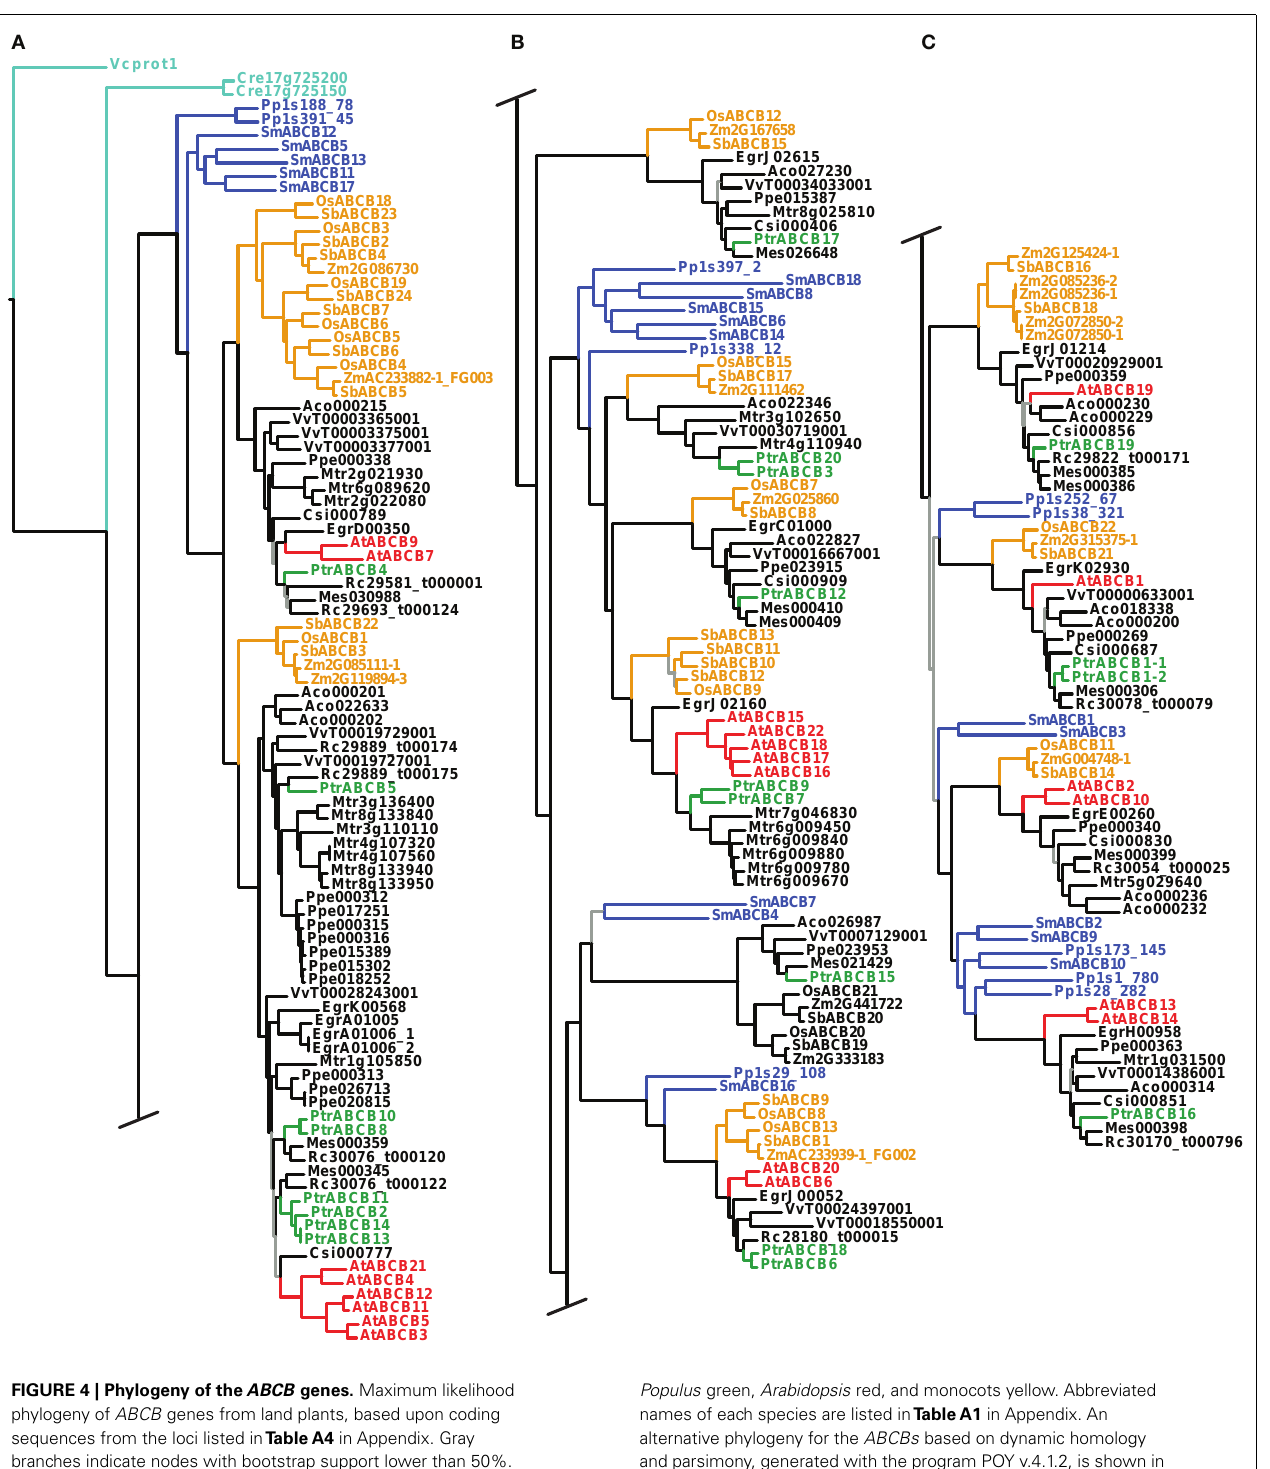
FIGURE 4 | Phylogeny of the ABCB genes. Maximum likelihood phylogeny of ABCB genes from land plants, based upon coding sequences from the loci listed in TableA4 in Appendix. Gray branches indicate nodes with bootstrap support lower than 50%. Algal ABCBs are colored light blue–green, basal land plants blue,